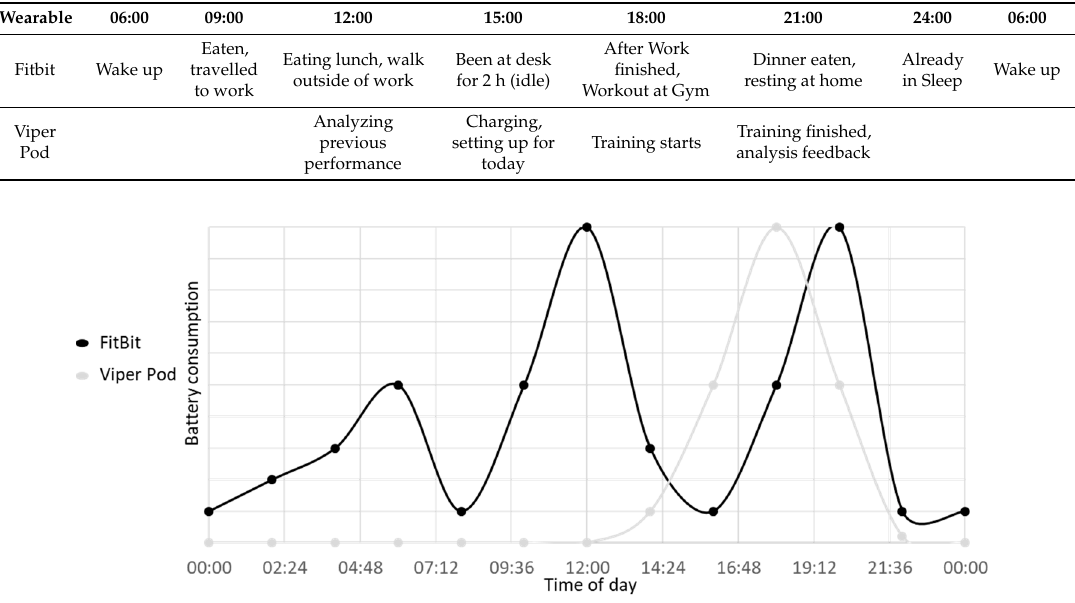
Figure 6. Example of potential battery consumption rate changes during the day for both wearables.